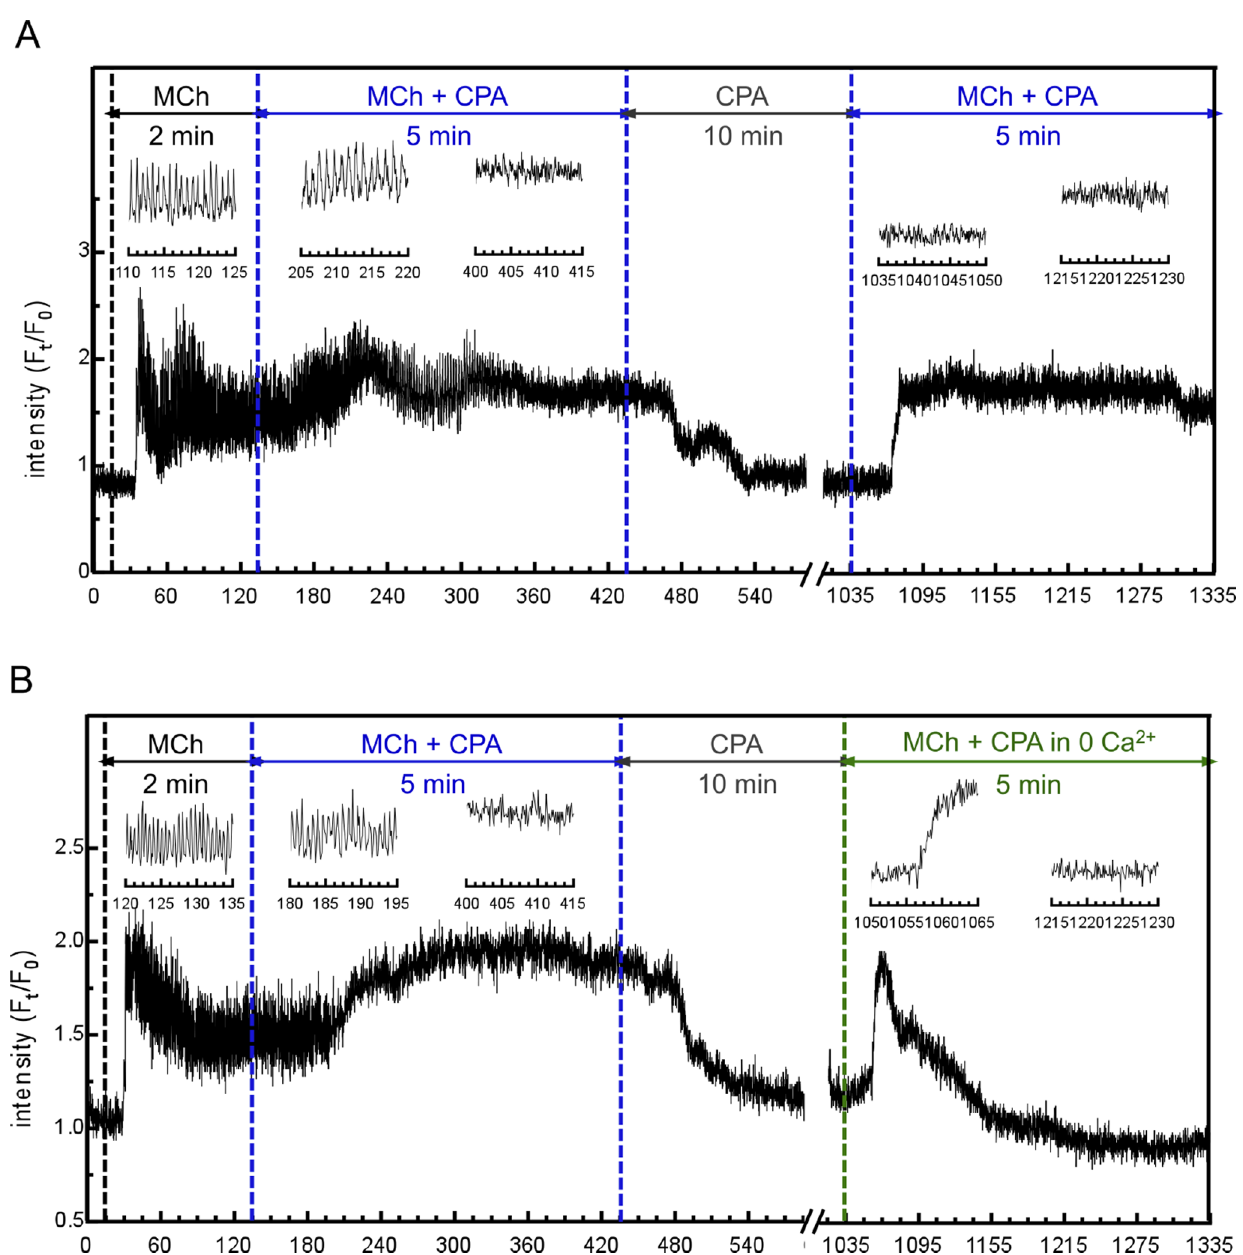
Figure 7. Experimental evidence that CPA does not fully empty the SR of ASMC. Tests of the model predictions shown in Fig. 6B–D, performed with mouse lung slices. (A) Significantly longer exposure to agonist + CPA and to CPA than in Fig. 6A still fails to maintain SOCE. (B) Same experiment as in (A) except that extracellular Ca 2 z is removed before agonist is applied a second time, confirming the residual presence of Ca 2 z in the SR and hence the partial efficacy of CPA to inhibit SERCA (scenario of Fig. 6D). (Insets show magnifications of selected time